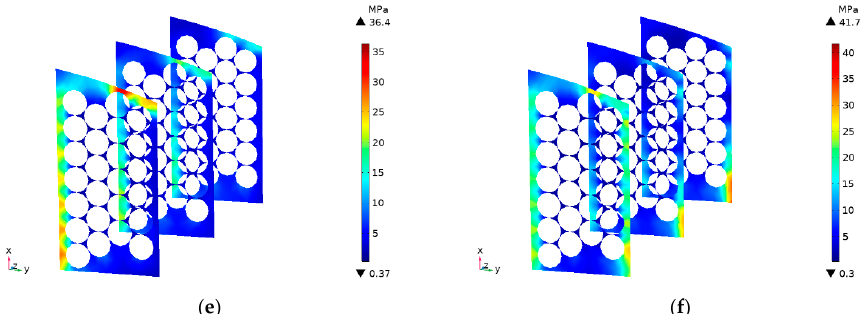
Figure 11. Resulting stress distribution for WJ1 + DCC1 and WJ2 + DCC2. ( a , b ) show the overall stress distribution; ( c , d ) show the stress in the copper coils; ( e , f ) show the stress in three different positions along the axial length of the machine.